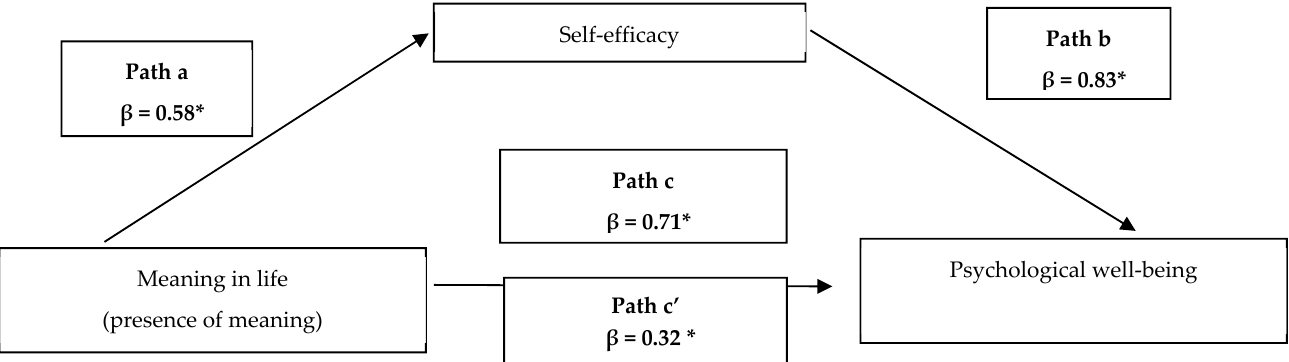
Figure 1. Model of the mediational role of self-efficacy in the relationship between meaning in life and psychological well-being. * p < 0.001.; β -standardized regression coefficient.